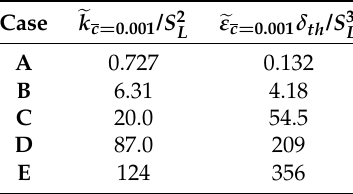
k normalised by its value at c = 0.001 with c for cases Figure 3. Variations of Figure 4: Variations of turbulent kinetic energy normalised by its value at c = 0 . 001 (cid:101) averaged combustion progress variable c for cases (a–e) A–E